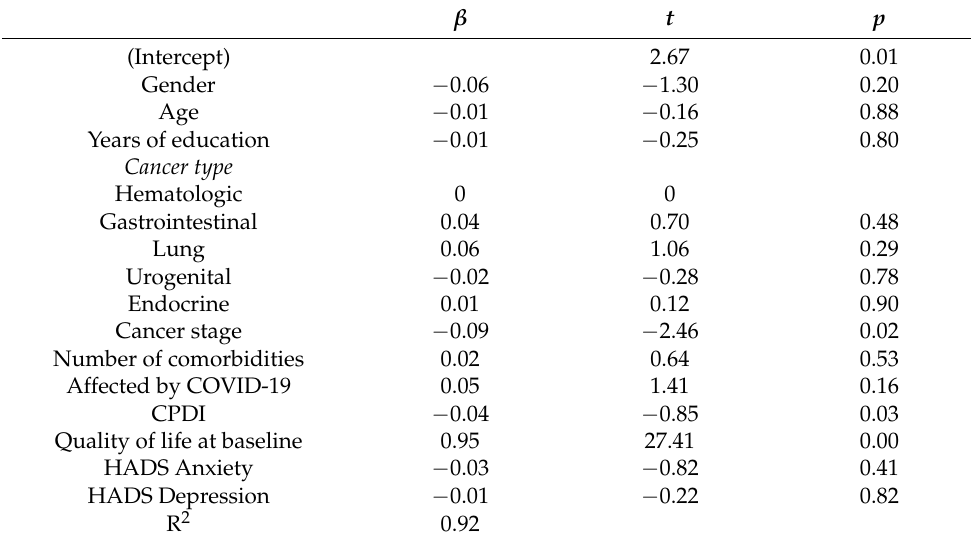
Table 4. Predictors of quality-of-life scores in cancer patients during the pandemic. β